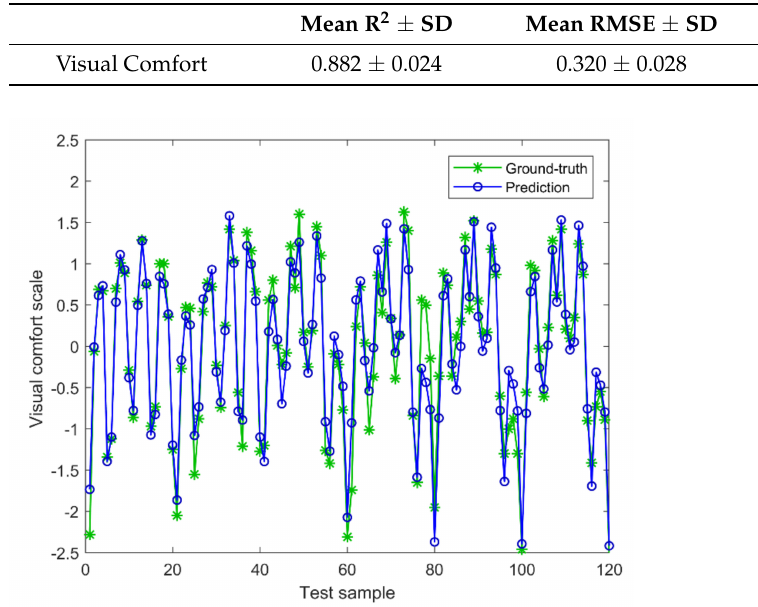
Figure 12. Fitting curve of the prediction.